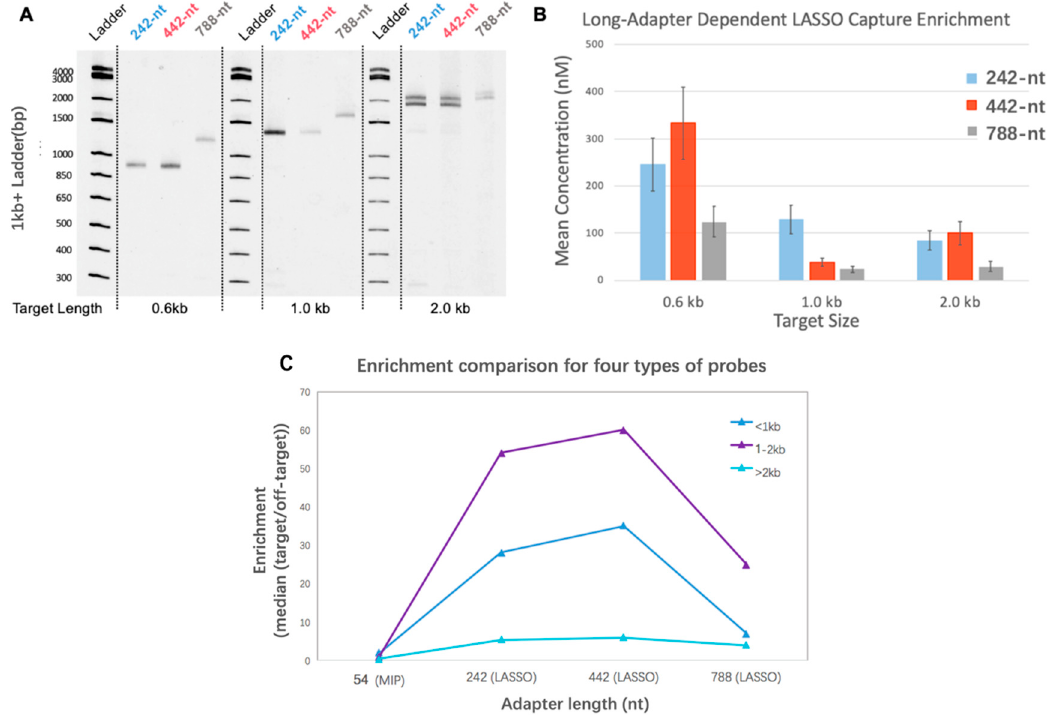
Figure 2. Dependence of capture efficiency on adapter length and target length. ( A ) Polyacrylamide gel electrophoresis (PAGE) visualization of amplified capture products for different adapter lengths and target sizes. ( B ) Single-target capture quantification from PAGE, each quantified with standard curves derived from DNA ladder serial dilutions with known band concentrations. P values that describe the confidence in the observed difference for different adapter lengths within each group of target sizes are measured to be 0.0068, 2.5 × 10 − 7 , and 4.1 × 10 − 6 . ( C ) Description of enrichment efficiency from sequences resulting from multiplex target cloning of Escherichia coli genes.